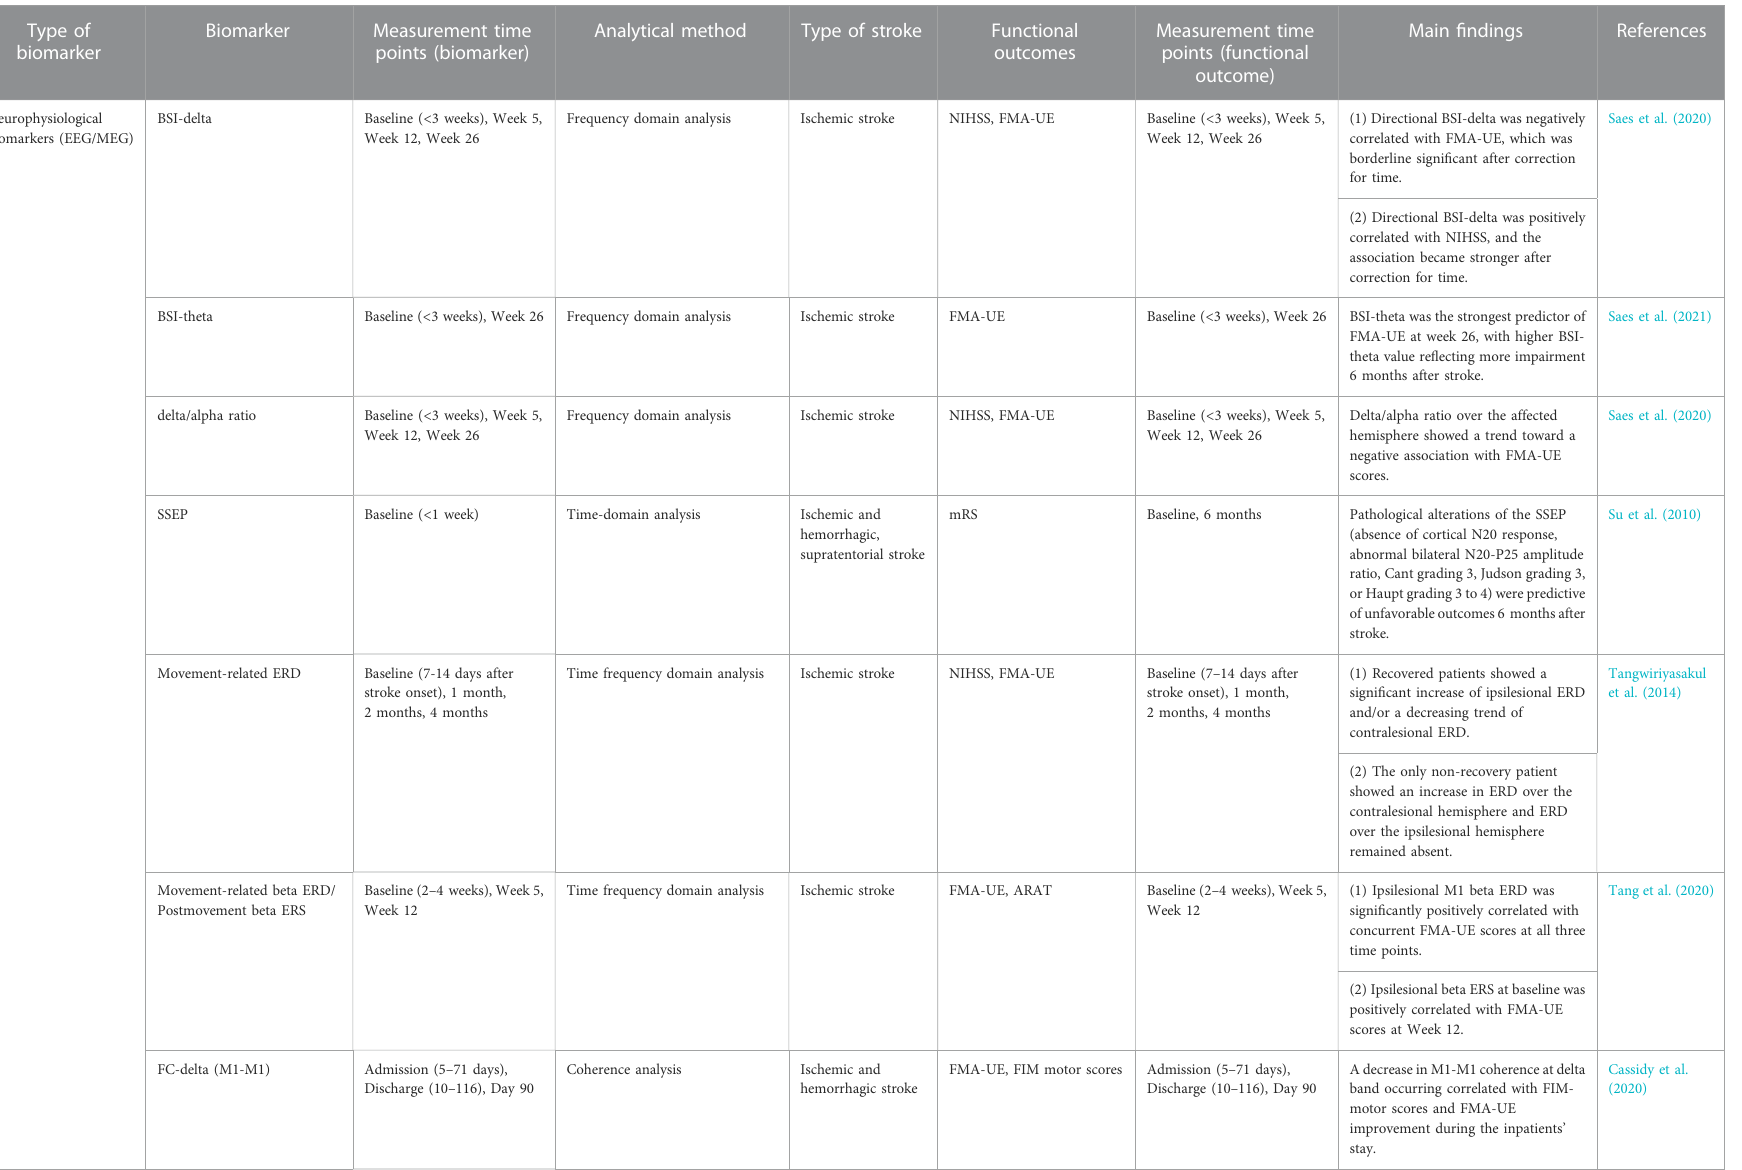
TABLE 1 Neurophysiological and neuroimaging biomarkers for stroke